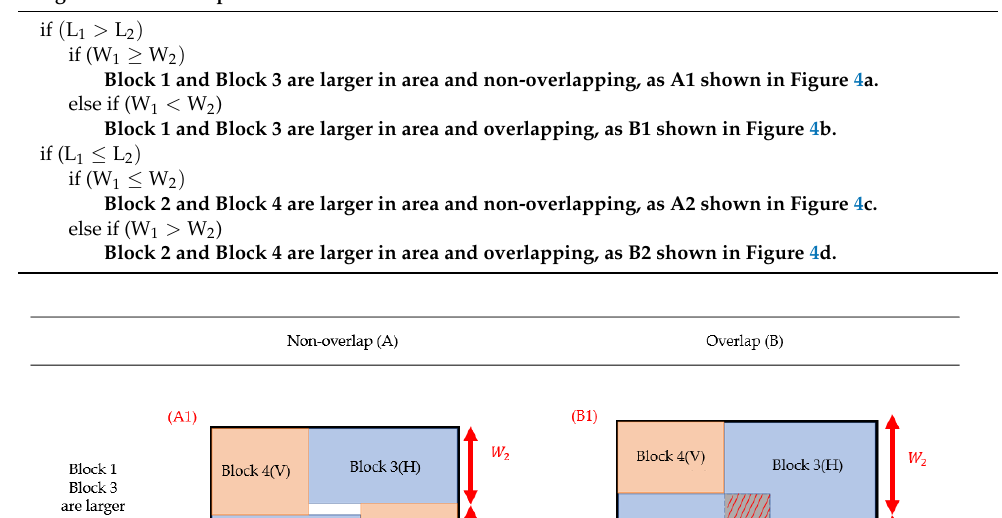
Figure 6. Vertical multi-object overlap.